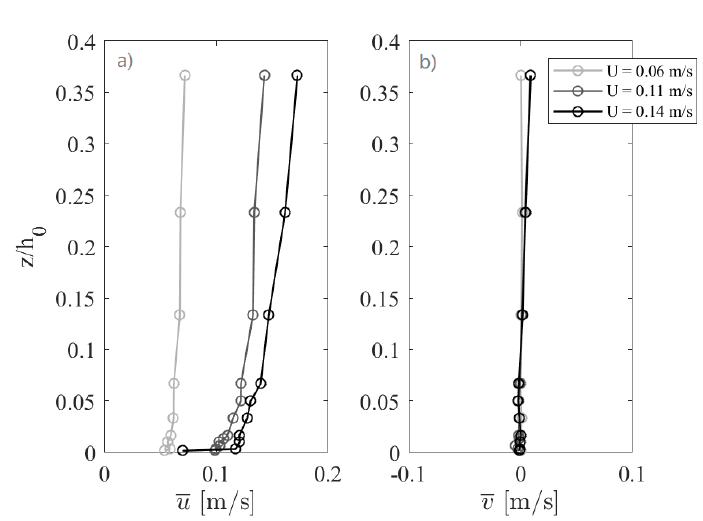
Figure 6. Dimensional time-averaged velocity profiles u ( a ) and v ( b ) directions for tests 1, 2 and 3 (CO). All the tests have the same position (CC, h = 0.26 m) but different U